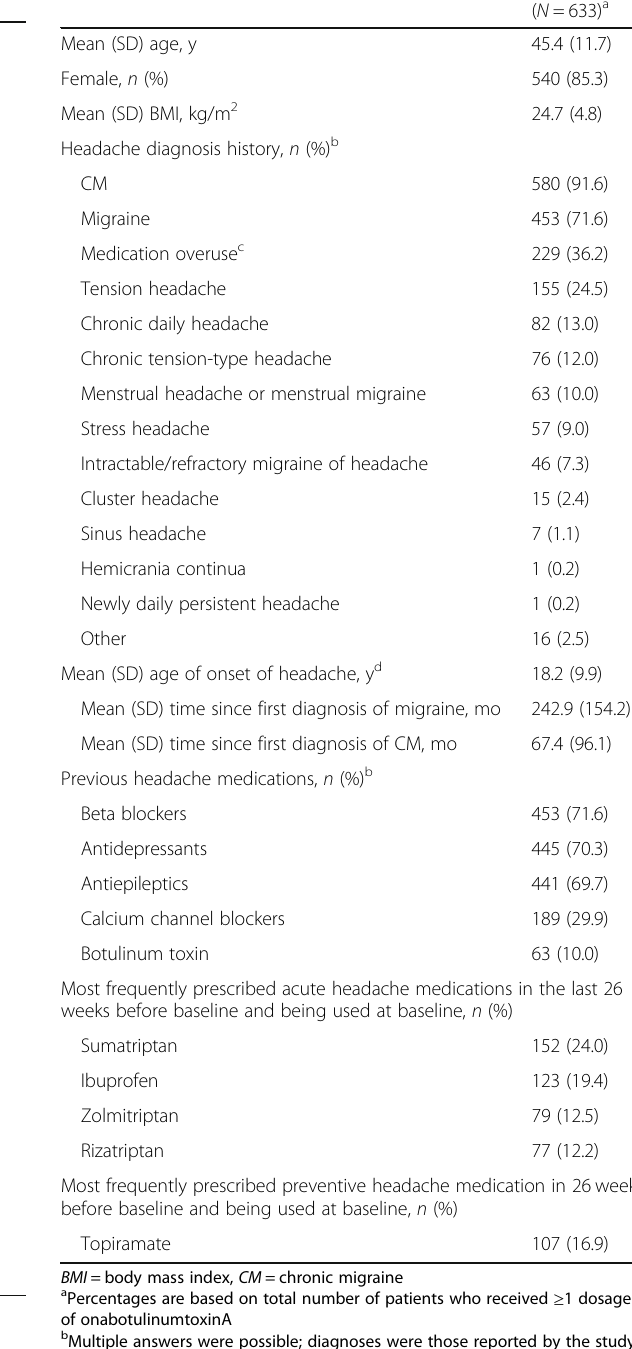
Table 2 Baseline demographics and